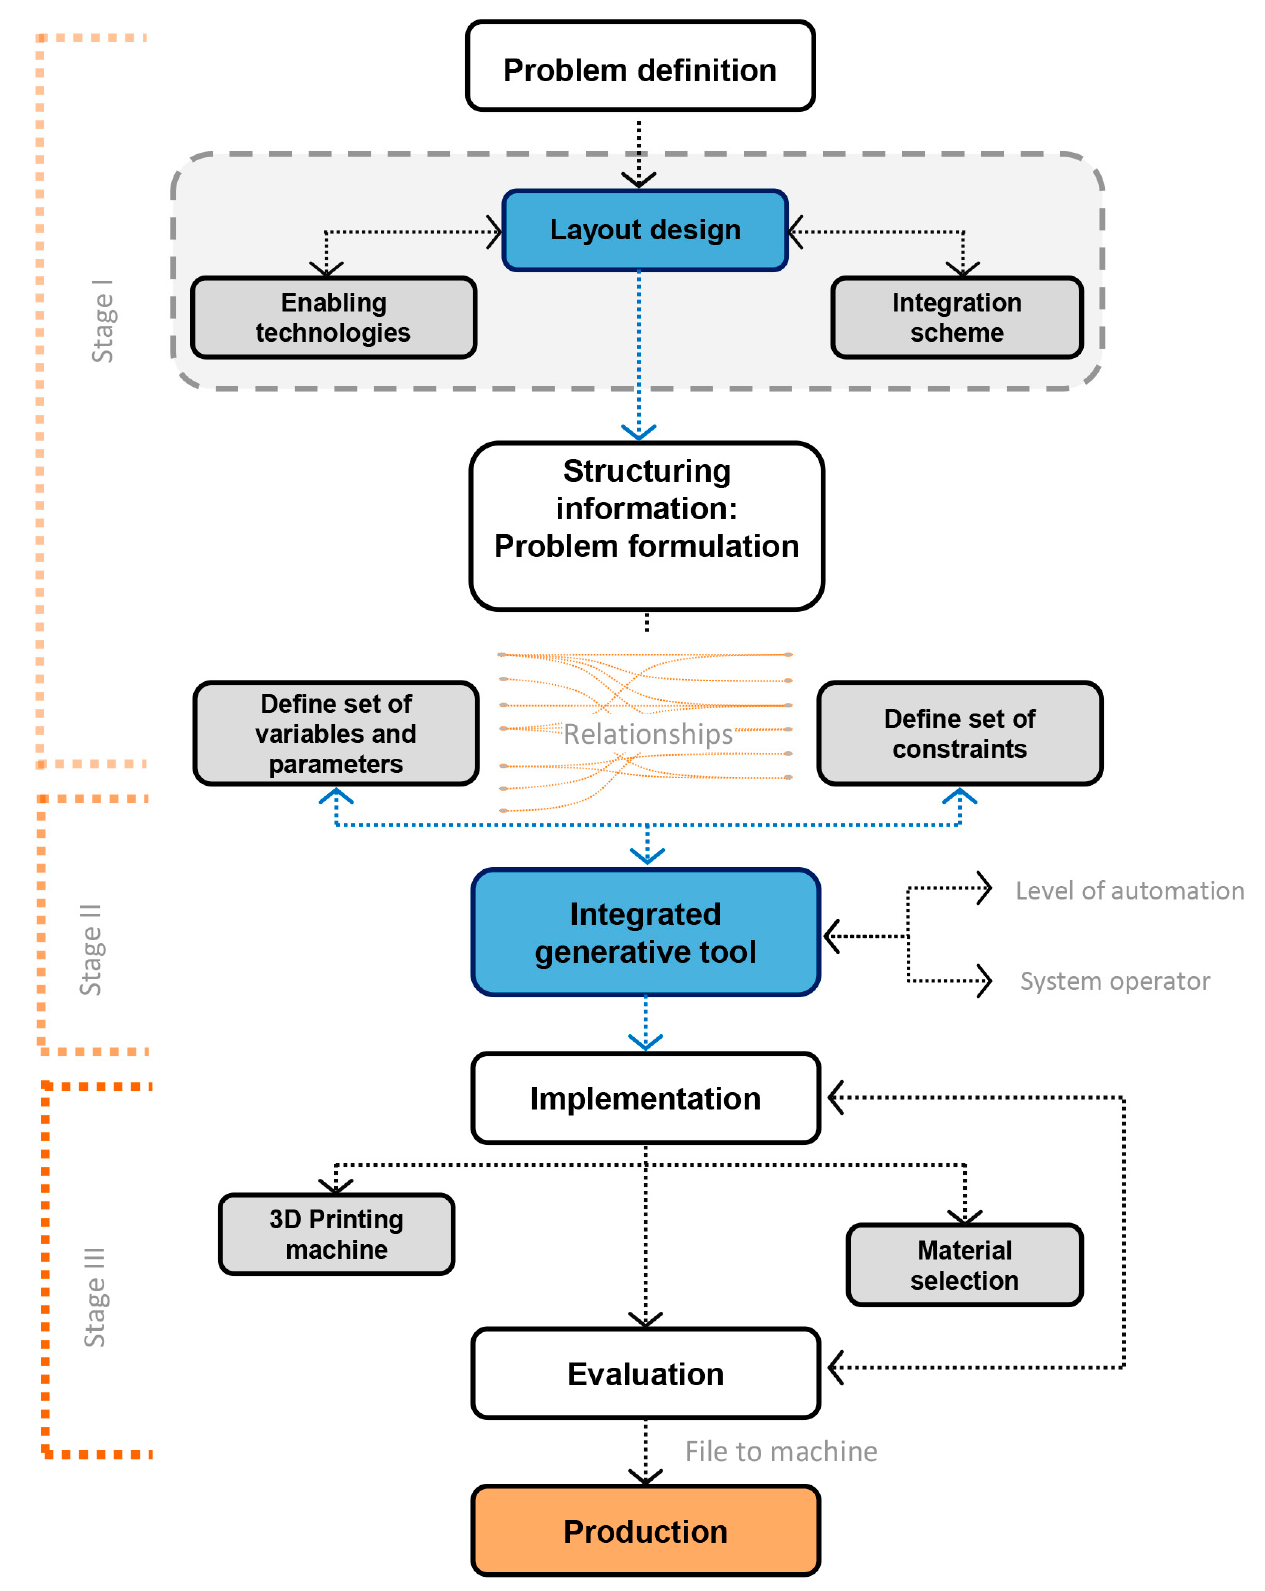
Figure 5. A diagrammatic representation of the a mass customization framework targeting higher level of customization in response to n emergent design and fabrication